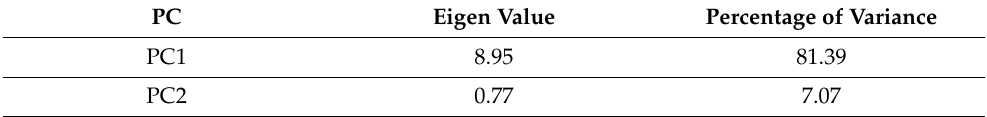
Table 6. Eigen values of percentage of variance of the principal components of yield